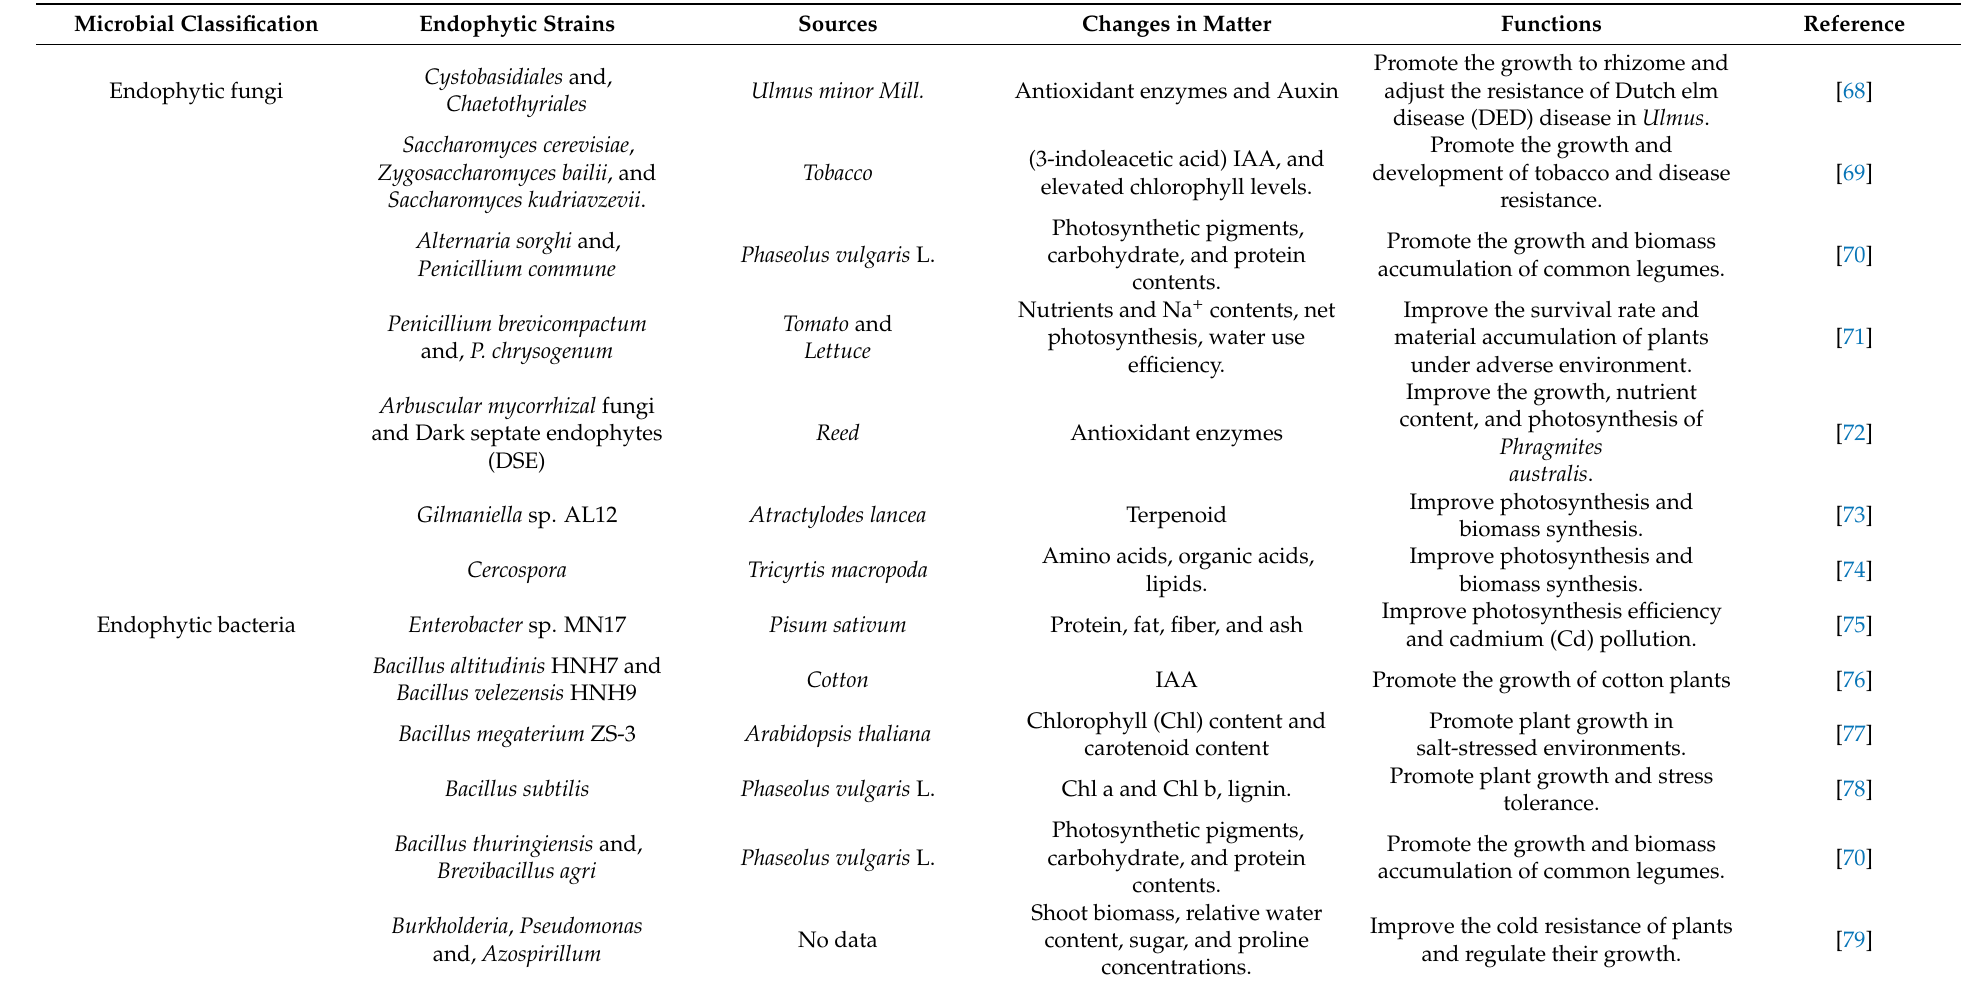
Table 1. Endophytes affect the accumulation of photosynthetic components in the